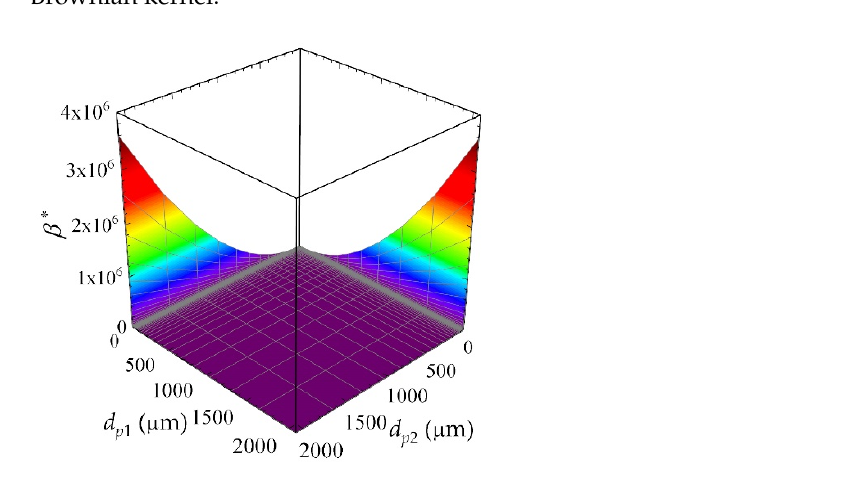
( b ) Figure 6. Mass density distribution q 3 simulated with the EKE kernel: ( a ) test without tenside; ( b ) test with tenside. The values of β 0 fitted to the DPB combined with different kernels are shown in Table 2. In all cases, the values of the aggregation rate obtained for the case with tenside additive are about ~32–33% higher than the values obtained when the additive was not added to the fertilizer solution. It has to be underlined that the different order of magnitude of the optimal value of β 0 found for each model is due to their different mathematical forms. In any case, the predictions obtained with all the adopted models, shown in Figures 7 and 8, respectively, for the tests performed without and with additive, are very similar, with the EKE kernel performing slightly better, especially after some time from the start of the pro- cess, i.e., at t = 20 min (Figures 7c and 8c). This finding is consistent with previous studies of Honslow [40], which indicate that the EKE kernel is most suitable for fluidized bed granulation. Furthermore, as also indicated in the above cited work, the results presented